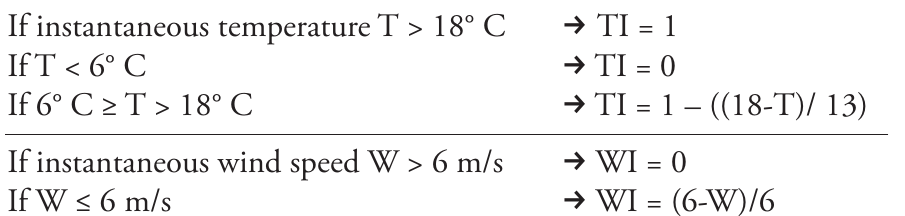
Table 1. Algorithm for computing Mosquito Activity Index (MAI) are adapted from Russell et al. (1993). MAI is computed for every 3-hourly period using instantaneous surface air temperature and wind speed data from the North American Regional Reanalysis (NARR) gridded climate dataset using this algorithm.